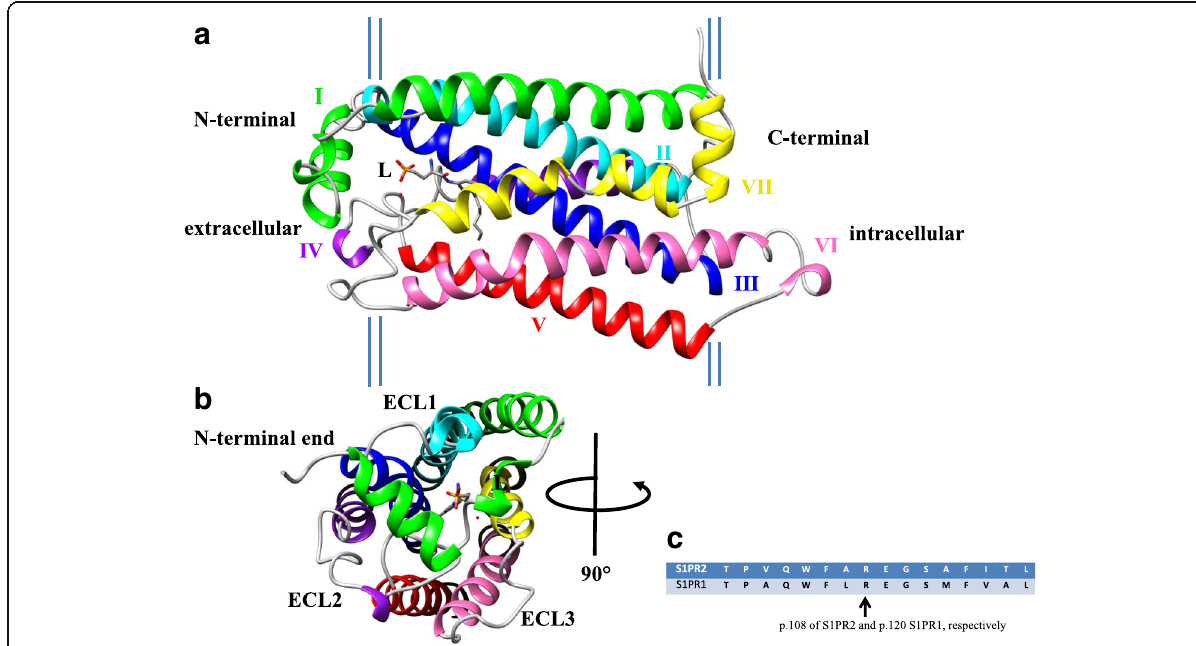
Fig. 3 3D homology model of WT S1PR2 protein structure. a Description of the single helices. Helix I includes the N-terminal end and is colored in green. Helix II (turquoise) and helix III (blue) form ECL1, helix IV (purple) and helix V (red) form ECL2, and helix VI (pink) and helix VII (yellow) form ECL3. L represents the ligand ML056, which mirrors the S1P ligand. b View of S1PR2 from the extracellular side. The ECLs and N-terminal end are marked. L describes the ligand ML056. c Partial human protein sequence alignments of S1PR2 and S1PR1 including p.108 and p.120,